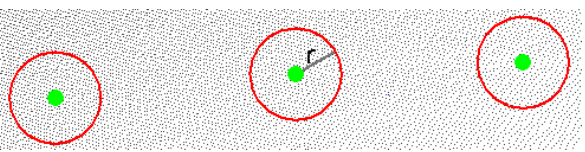
Figure 5. Circle (with radius r) in each trajectory